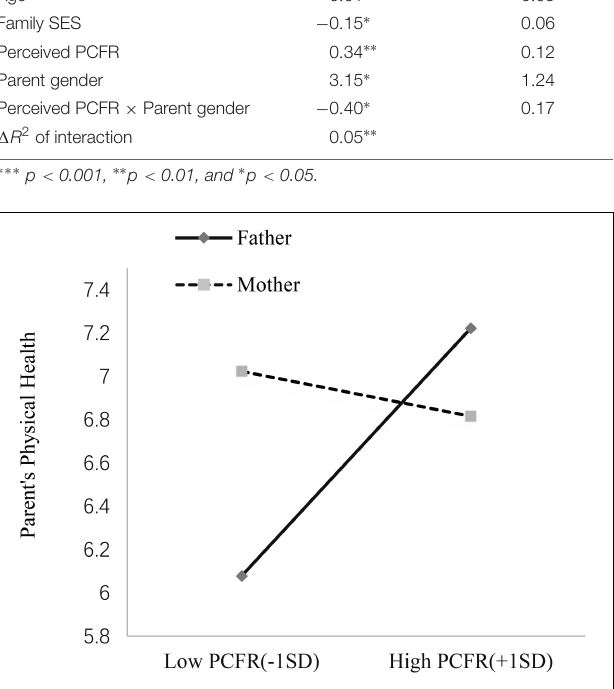
FIGURE 2 | The moderating effect of parent gender on the relationship between PCFR and parental physical health in this study. The figure depicts the physical health score corresponding to –1SD and +1SD of PCFR for both parents. The slope was significant for fathers, but not for